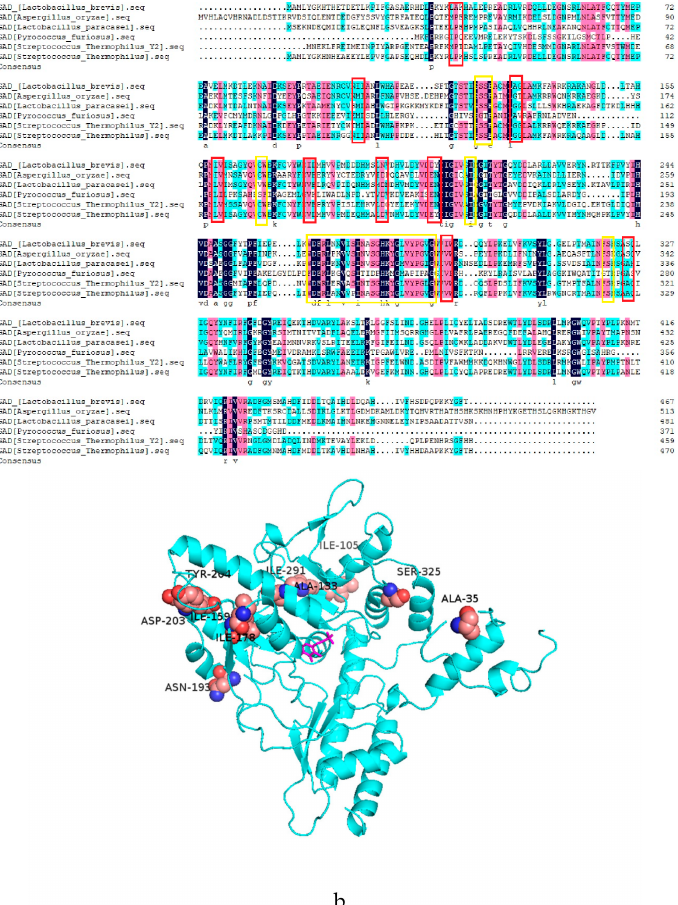
Figure 1. Putative important residues in glutamate decarboxylase identified by sequence analysis. ( a ) Sequence alignment of glutamate decarboxylase from L. brevis and other five glutamate decarboxylases (GADs). The amino acid sequences of GADs were aligned with the DNAMAN program using default parameters. The important residues of GAD are indicated with a yellow box. The consensus residues are indicated with a red box. ( b ) The consensus residues were visualized in the crystal structure of GAD (PDB ID:5GP4). Ten residues, Ala35, Ile105, Ala133, Ile159, Ile178, Asn193, Asp203, Tyr204, Arg225, and Ser325, are shown as spheres. The pyridoxal 5-phosphate (PLP) is shown as